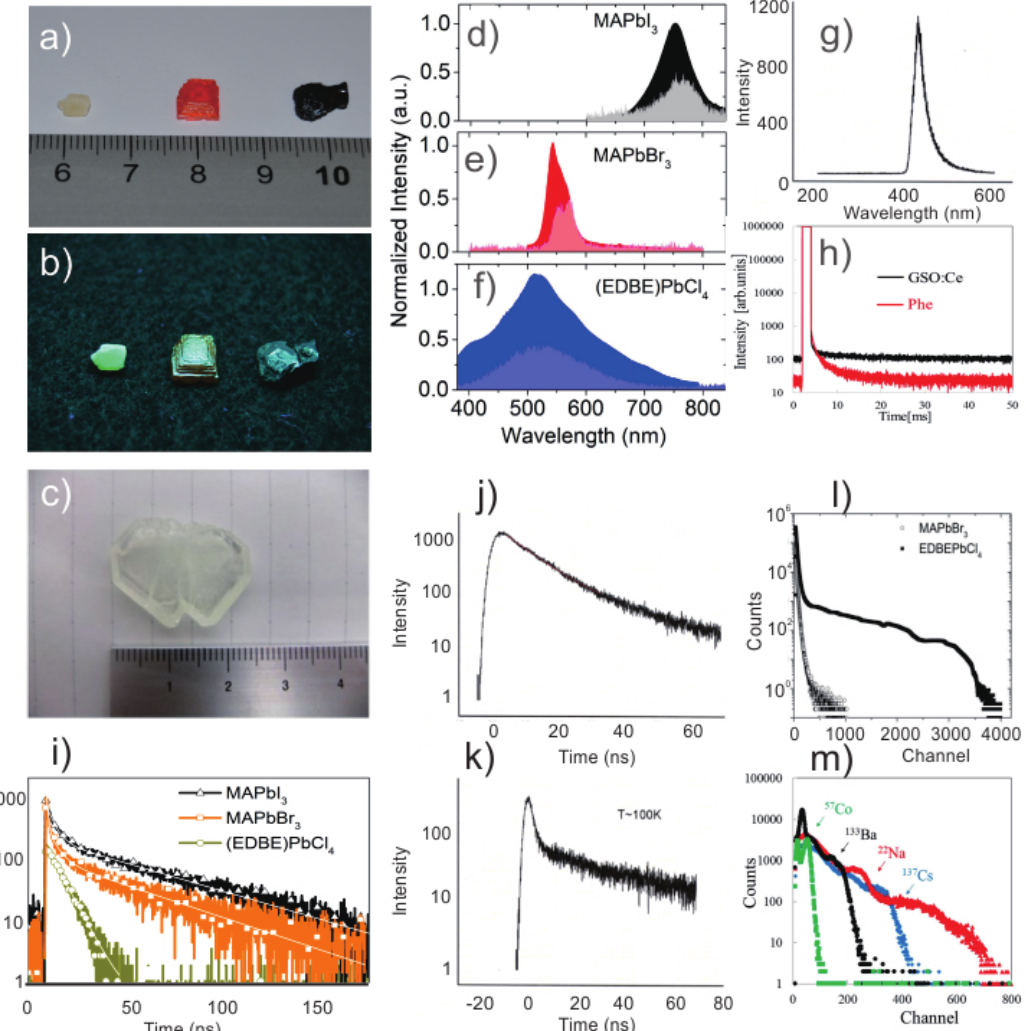
Figure 5. Perovskite single crystal scintillators: ( a ) A photographs of the large single crystals of hybrid lead halide perovskites. From left to right: ( EDBE ) PbCl 4 (two-dimensional scintillator), MAPbBr 3 and MAPbI 3 (both are three-dimensional scintillators). ( b ) Glow of the crystals under ultraviolet lamp excitation from the above crystals. ( c ) Another photograph of large two-dimensional perovskite (( C 6 H 5 C 2 H 4 NH 3 ) 2 PbBr 4 ) or Phe ). ( d , e , f ) X-ray excited luminescence (light color area) and photoluminescence (dark color area) spectra of three crystals in ( a ) with excitation wavelengths for photoluminescence of 425, 500, and 330 nm, respectively. Photoluminescence and X-ray excited luminescence spectra were normalized to their maxima, and normalized X-ray excited luminescence spectra were divided by a factor of two for clarity. ( g ) X-ray excited emission spectra of Phe. ( h ) X-ray induced afterglow time profiles of Phe with that of Gd 2 SiO 3 : Ce 3 + as a comparison. ( i ) Time-resolved emission curves of ( EDBE ) PbCl 4 , MAPbBr 3 and MAPbI 3 recorded under 330, 370 and 640 nm excitation and by monitoring 520, 540 and 766 nm emission, respectively. ( j , k ) Scintillation decay curves of Phe under pulsed X-ray excitation. ( l ) Pulse height spectra of ( EDBE ) PbCl 4 and MAPbBr 3 under 137 Cs γ -ray excitation. ( m ) Pulse height spectra of Phe under different γ -ray excitations. All measurements beside that in ( k ) (100 K) were measured at RT. Figures reproduced from ( a , b , d , e , f , i , l ) Birowosuto, M. D., Sci. Rep. 2016 , 6, 37254. 2016 by Springer Nature; ( c , h , m ) Kawano, N. et al., Sci. Rep. 2017 , 7, 14754. 2017 by Springer Nature; ( g , j , k ) van Eijk, C. W. E. et al., IEEE Nucl. Sci. Symp. Conf. Rec. 2008 , N69-3, 3525-3538. 2008 by